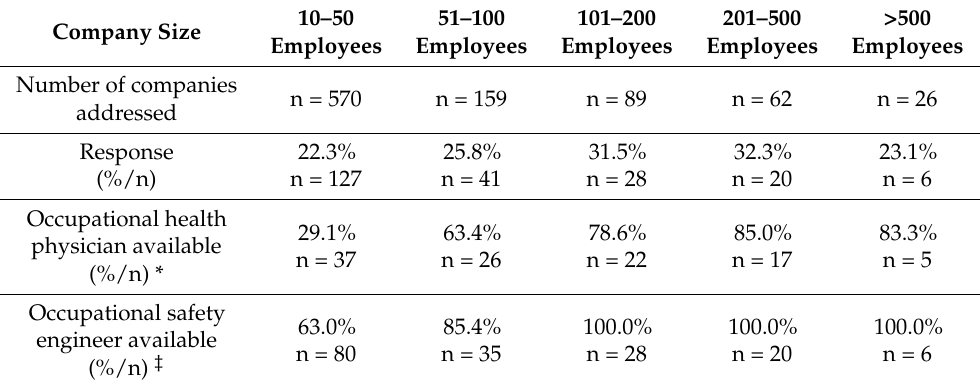
Table 1. Company characteristics according to company size (source: